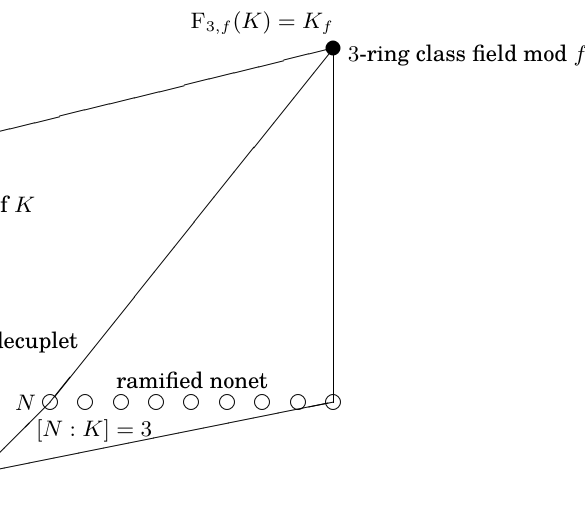
Figure 10: Heterogeneous tridecuplet modulo f = 2 over K .